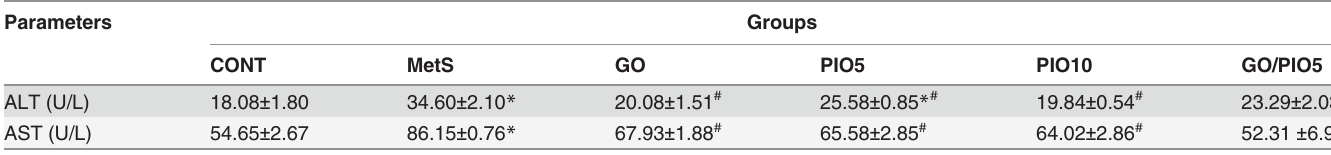
Table 4. Effect of 4 weeks daily oral administration of geraniol (GO; 250 mg/kg), pioglitazone (PIO; 5 and 10 mg/kg), and GO with PIO5 on serum alanine amino transferase (ALT) and aspartate amino transferase (AST) levels in fructose-induced metabolic syndrome (MetS) in rats.